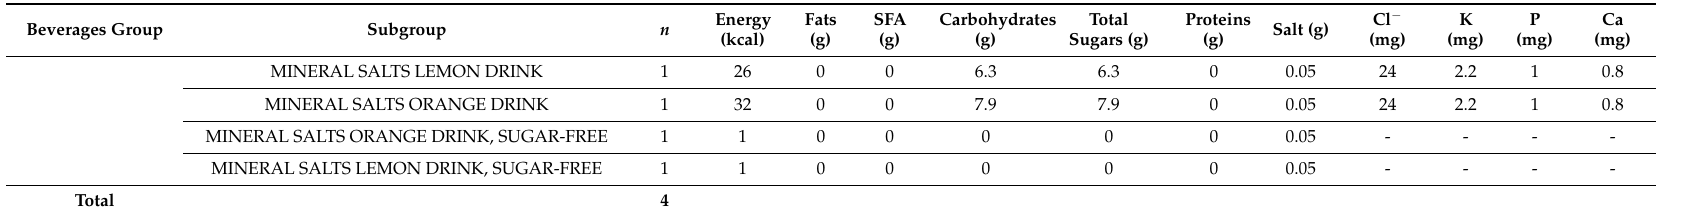
Data are expressed per 100 mL; SFA: Saturated fatty acids; (-): Data not